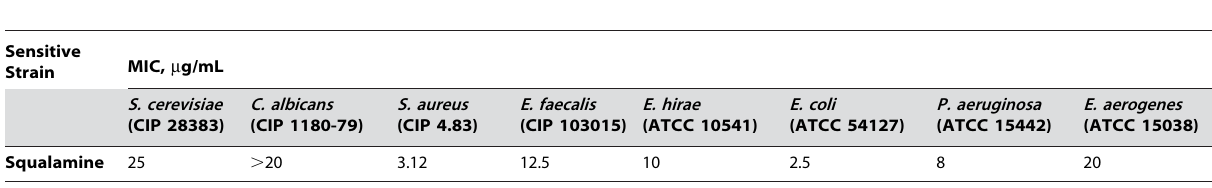
Table 1. Antimicrobial activities of squalamine 1